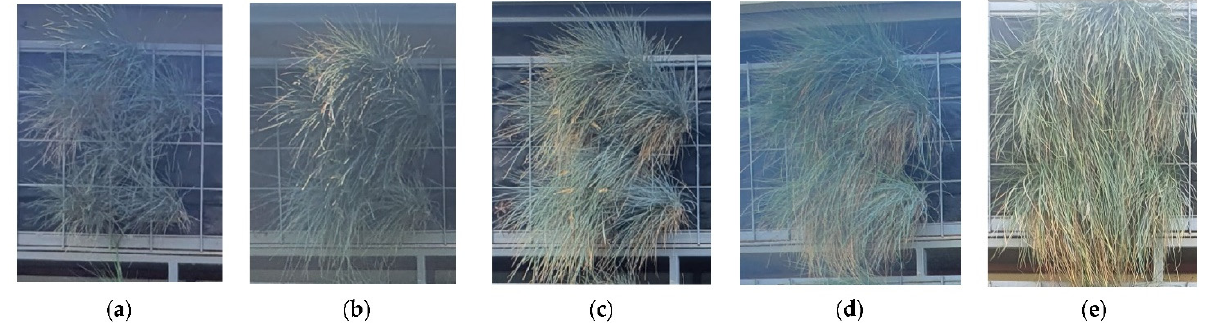
Figure 11. Festuca glauca May–December 2020, level 4 northern facade: ( a ) May; ( b ) June; ( c ) July; ( d ) October; and ( e ) December.